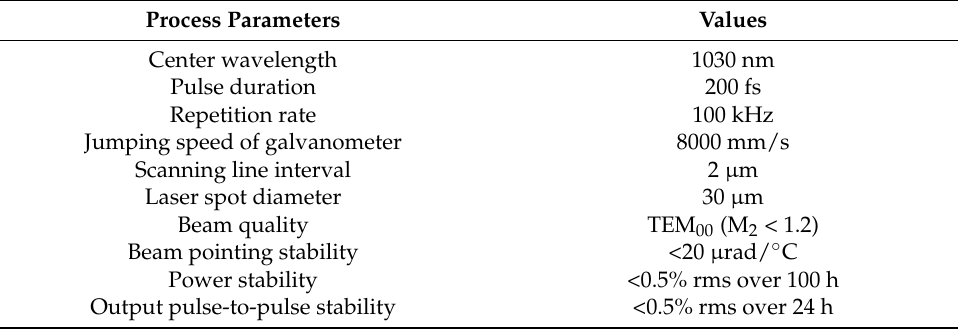
Figure 4. Experimental setup for femtosecond laser micromachining of the 4H-SiC sample. Table 1. Process parameters of the femtosecond